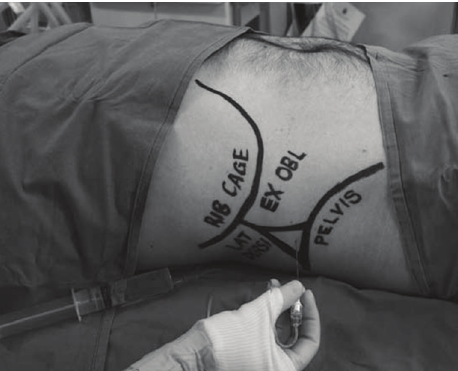
Figure 1: Surface anatomical landmarks can be utilized to identify the triangle of Petit [9]. Reproduced with